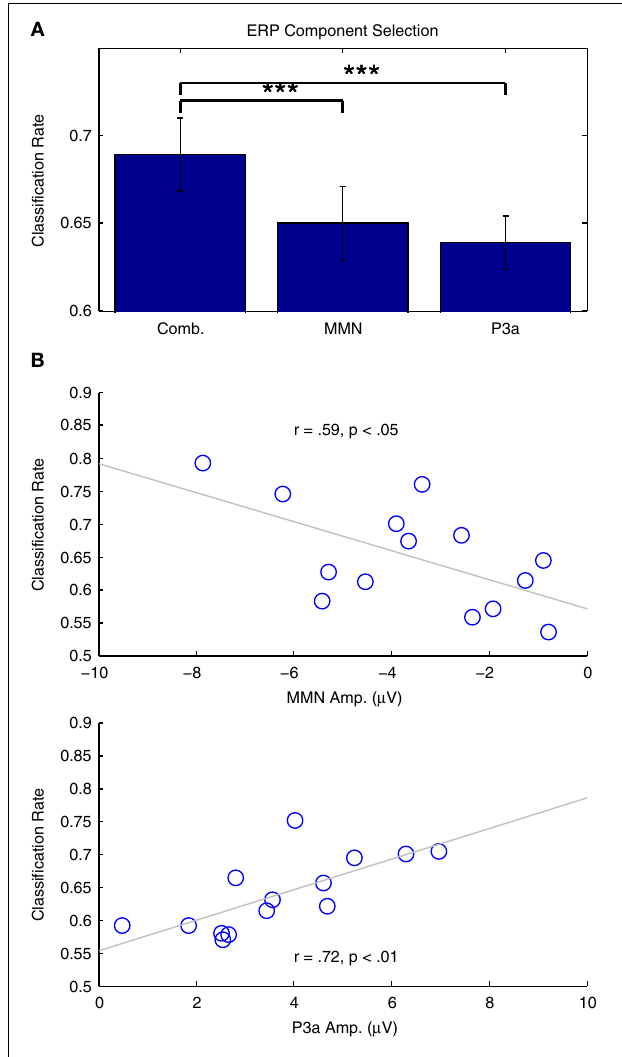
FIGURE 9 | Classification of individual ERP components. (A) Two classification analyses were performed using individual participant’s data from Dataset 1. Subsets of the data from the time windows associated with the MMN (82–207ms) and P3a (238–363ms) were selected and classified. Relative to analyses using the entire time range ( − 50 to 450ms), cross-validation rates in both of these analyses were significantly lower, indicated using asterisks: ( ∗∗∗ p < 0 . 001 B ) Correlation analyses of the individual results with the ERP component amplitudes measured using the individual difference waves were significant for both the MMN and P3a, indicating that classifier performance is strongly related to the amplitude of these components.